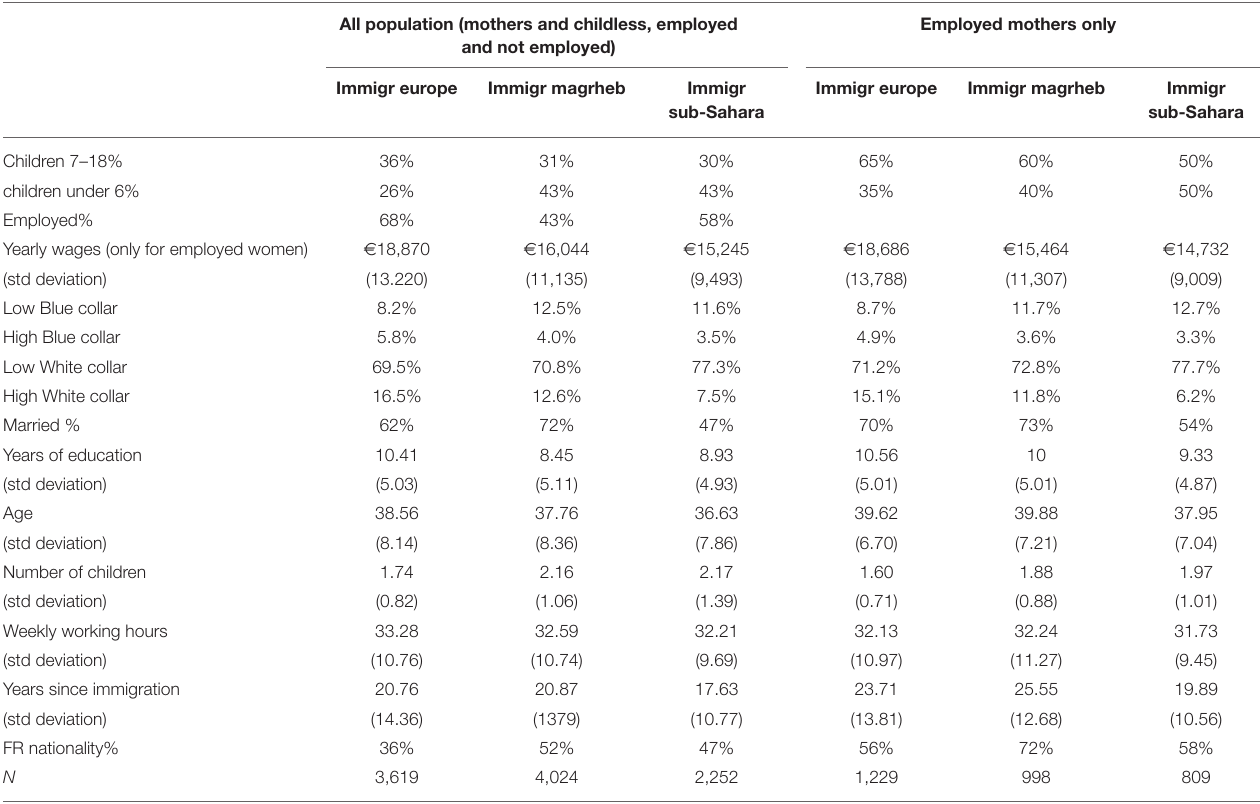
Employed mothers